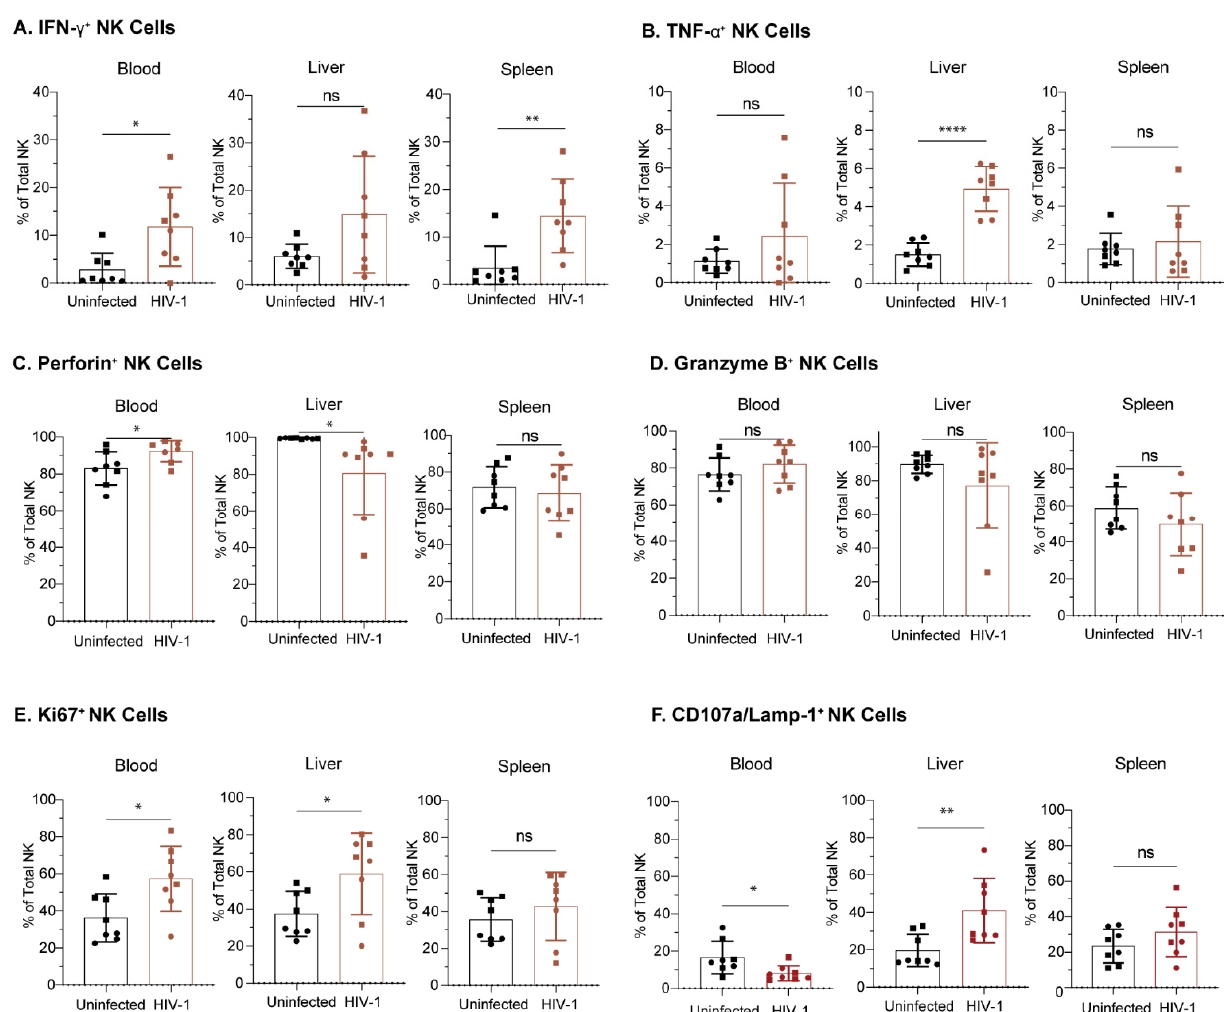
Figure 7. NK cells from Hu ‐ NSG ‐ Tg(IL ‐ 15) mice display a functional phenotype during acute HIV ‐ 1 infection. Percentage of NK cells expressing ( A ) IFN ‐γ , ( B ) TNF ‐α , ( C ) perforin, ( D ) granzyme B, ( E ) Ki67, or ( F ) CD107a (Lamp ‐ 1) in the peripheral blood, spleen, and livers of Hu ‐ NSG ‐ Tg(IL ‐ 15) mice, 8 weeks post HIV ‐ 1 infection. Mice from matched donors are denoted by